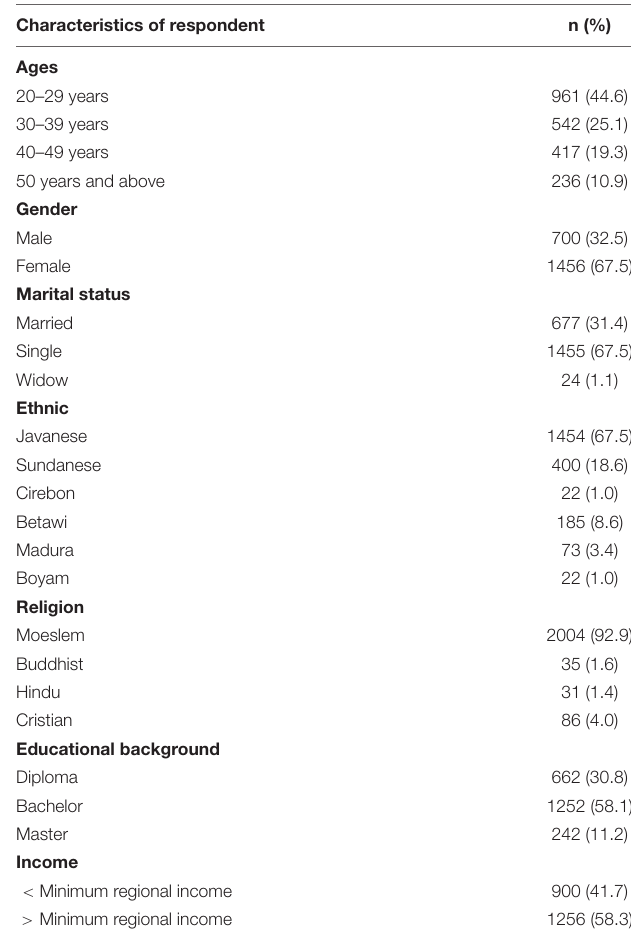
TABLE 1 | Sociodemographic characteristics of